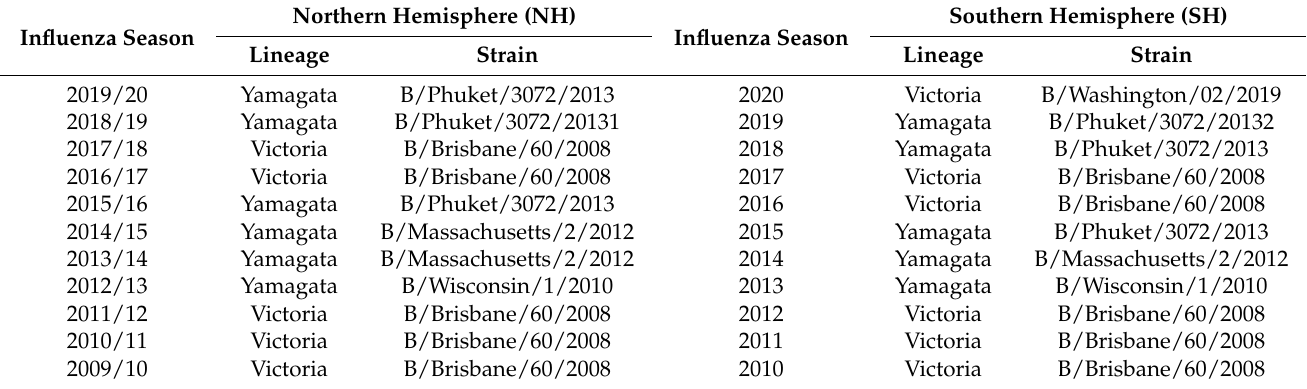
Table 3. WHO recommended influenza vaccine composition in the respective influenza